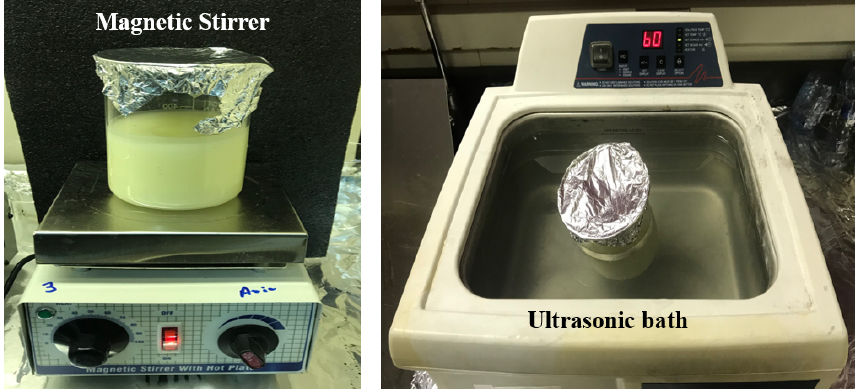
Figure 2. Magnetic stirrer and ultrasonic bath used to disperse Al 2 O 3 nano-additives in the vegetable oil.